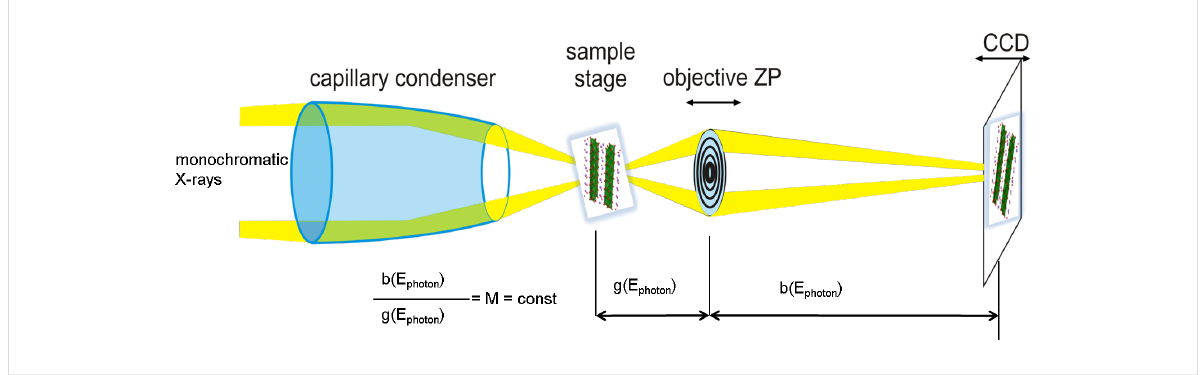
Figure 5: Schematic setup of the HZB-TXM for NEXAFS studies: Monochromatic X-rays are collected with an achromatic capillary condenser to illu- minate the sample. At each photon energy a highly magnified 2D image of the sample is taken whereupon the magnification (M) is kept constant